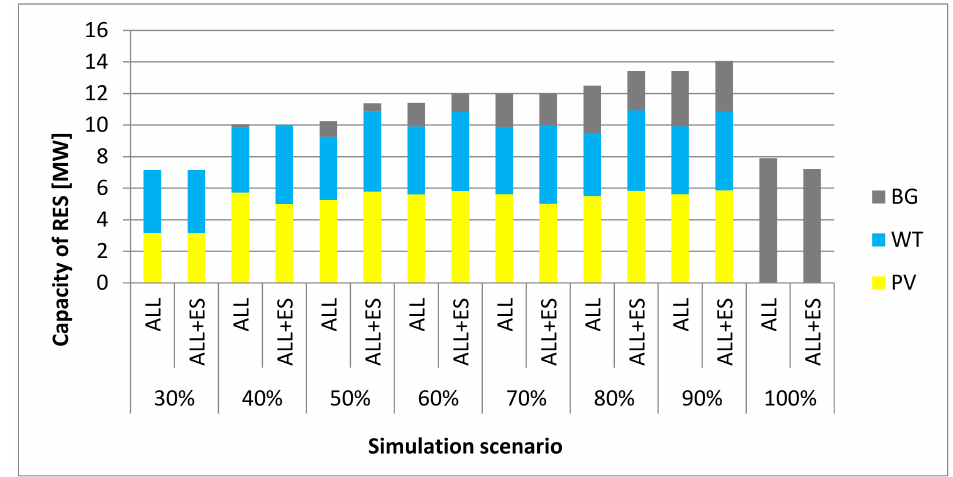
Figure 7. Capacity structure for simulation